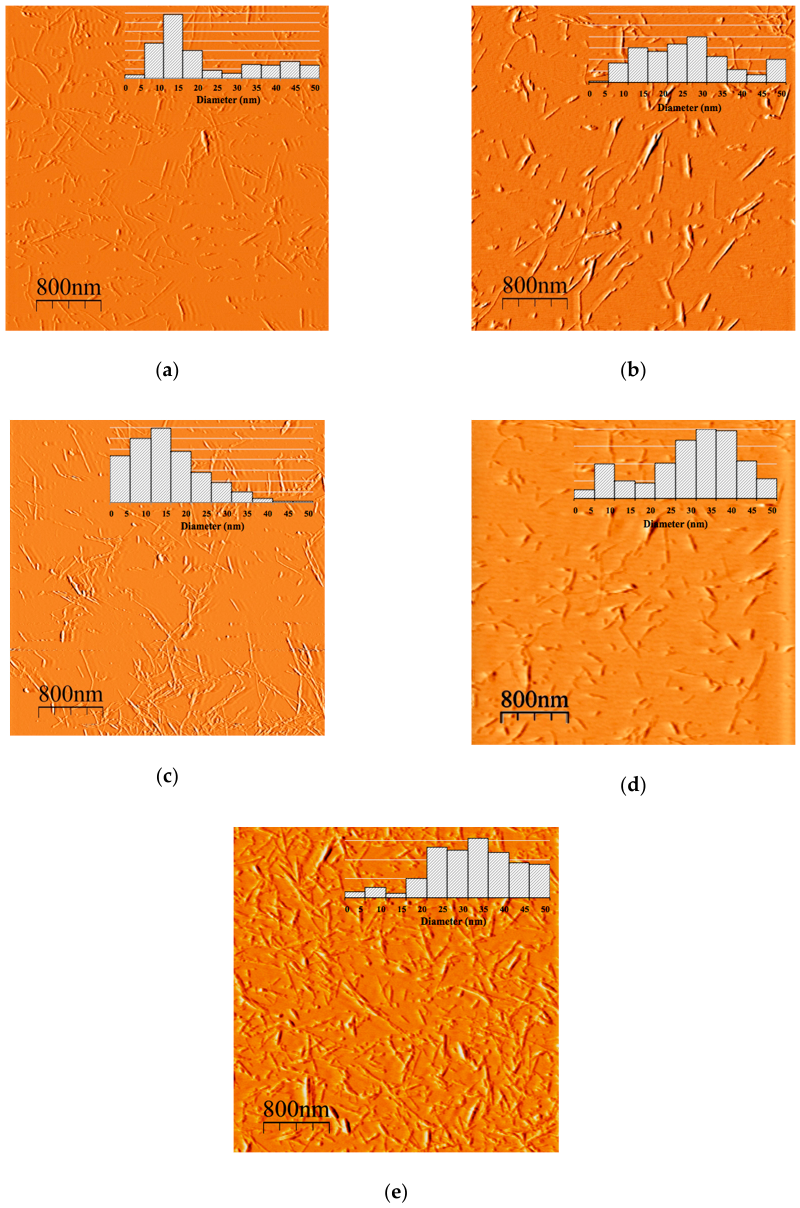
Figure 2. Atomic force microscope (AFM) images of the CNCs were analyzed. Each AFM image contains its graph of diameters size distribution. ( a ) Sample A; ( b ) sample B; ( c ) sample C; ( d ) sample D and ( e ) sample E.